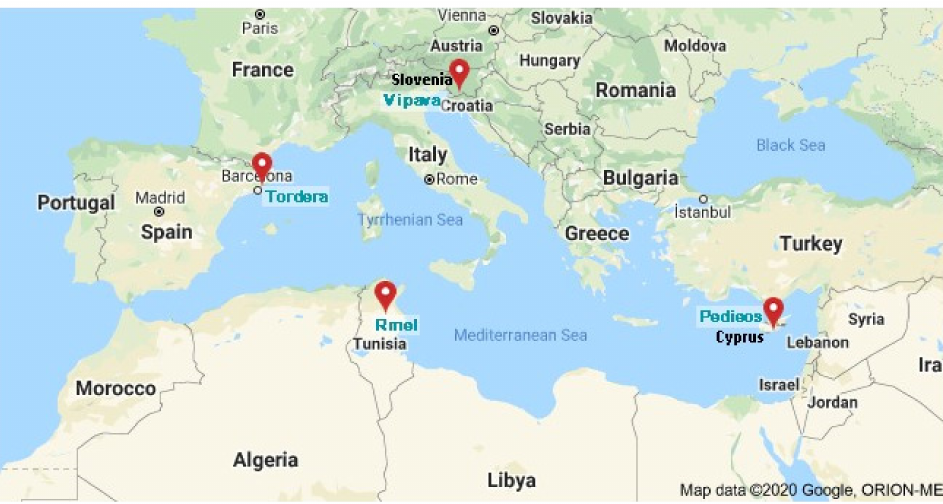
Figure 1. Location of the four case study river